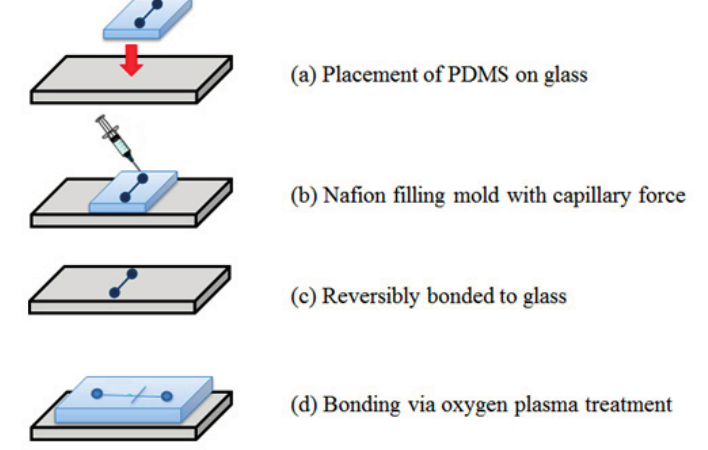
Figure 2. Schematic illustration of fabrication process for pattened